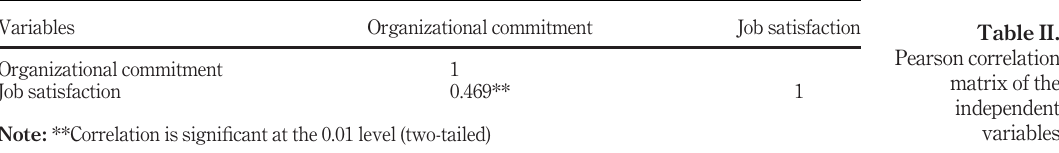
Table II. Pearson